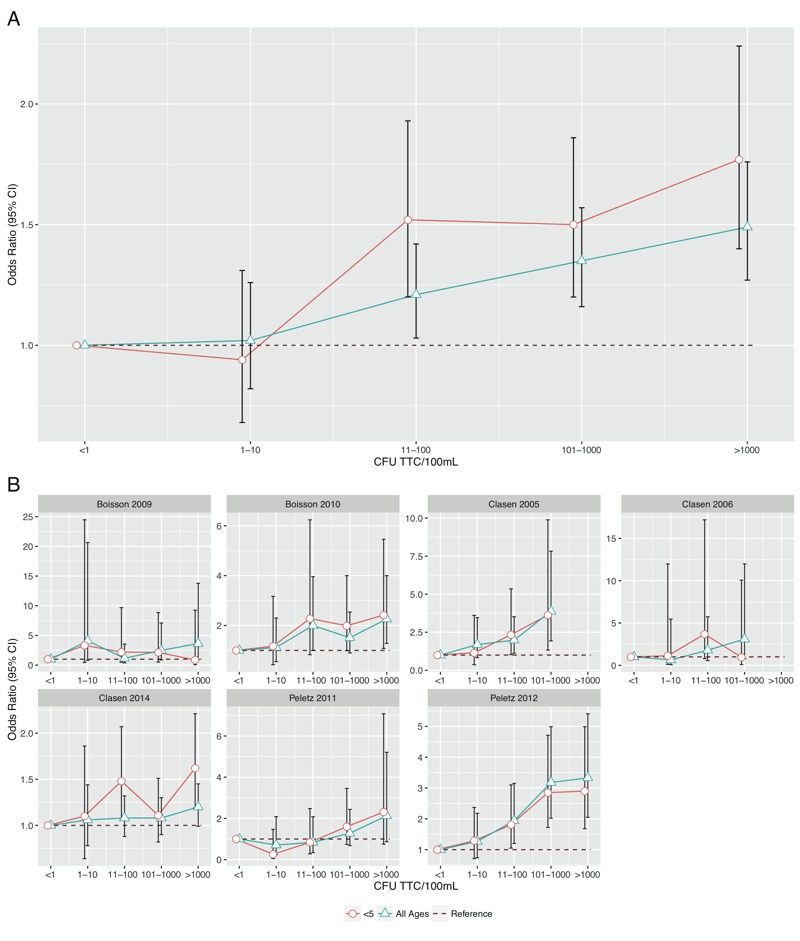
Adjusted odds ratios and 95% confidence intervals for WHO risk categories (with < 1 TTC/100 mL as references) for (A) all studies combined and (B) each study individually.